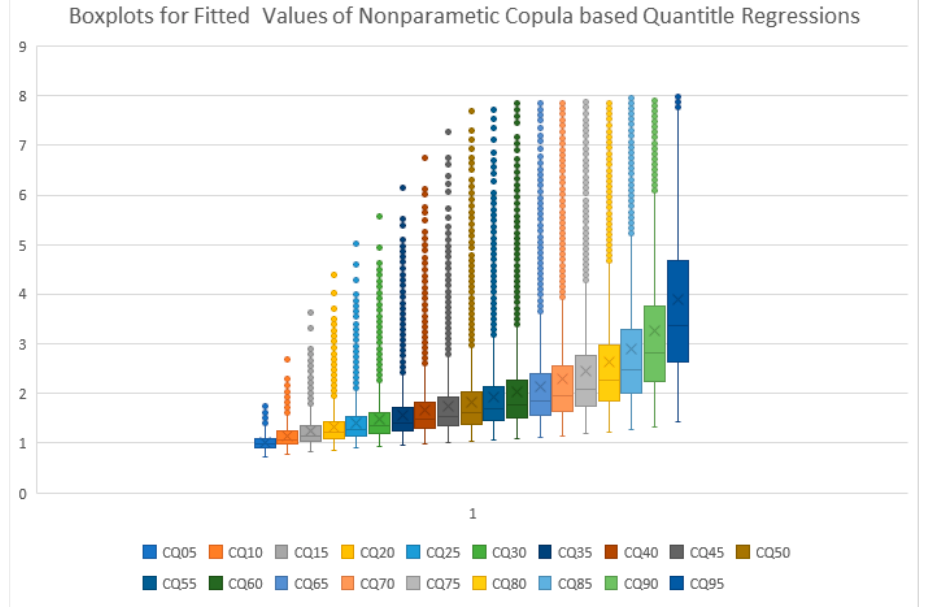
Figure 4. Plots for Fitted values of Nonparametric Copula based Quantile Regressions.